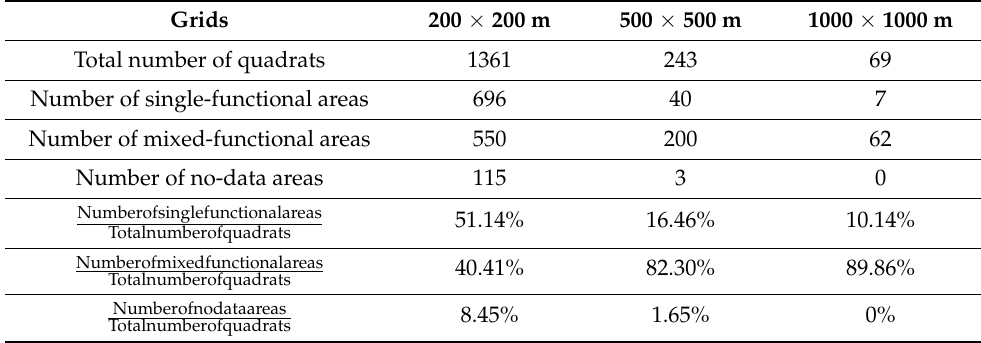
Table 3. Impact of the different grid sizes on the identification of urban functional